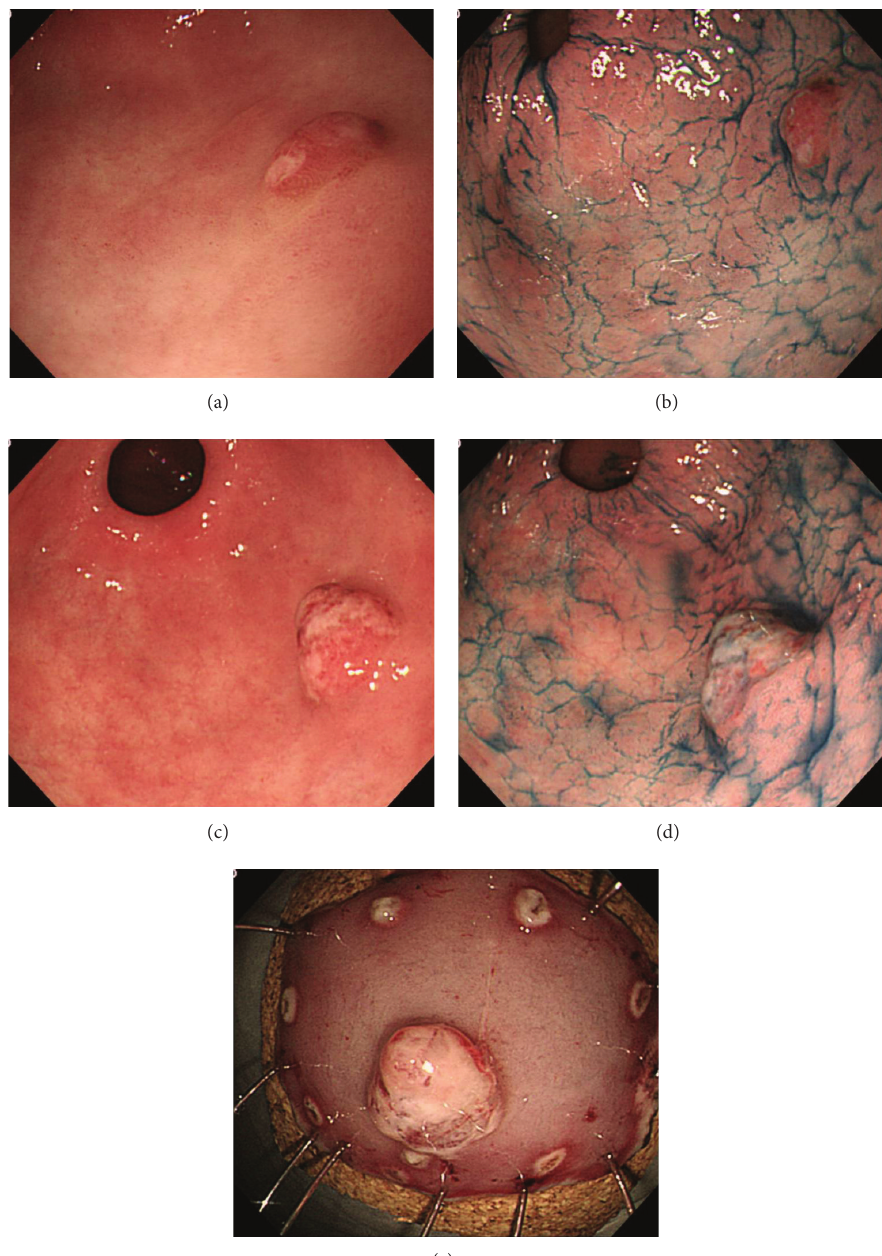
Figure 1: Case 1, endoscopic examination. EGD examination in April 2013 ((a) white-light endoscopy; (b) white-light endoscopy with indigo- carmine dye staining). EGD examination in April 2014, when an initial diagnosis of focal cancer within gastric HP was made ((c) white- light endoscopy; (d) white-light endoscopy with indigo-carmine dye staining). Endoscopic findings after en bloc resection by ESD (e). EGD: esophagogastroduodenoscopy; HP: hyperplastic polyp; ESD: endoscopic submucosal